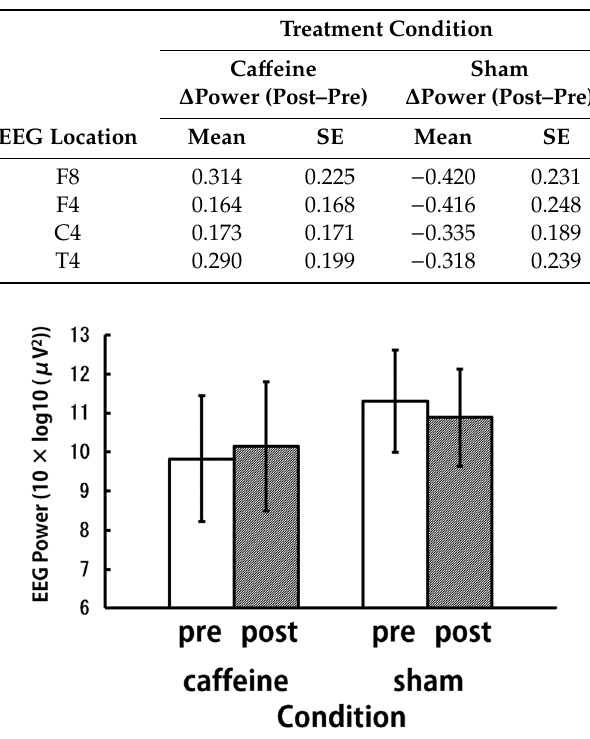
Figure 7. Theta activation at F8 during the letter 3-back working memory task ( N = 9).